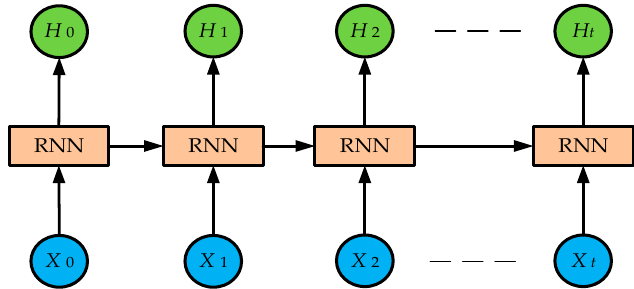
Figure 2. Expanded schematic of the RNN.